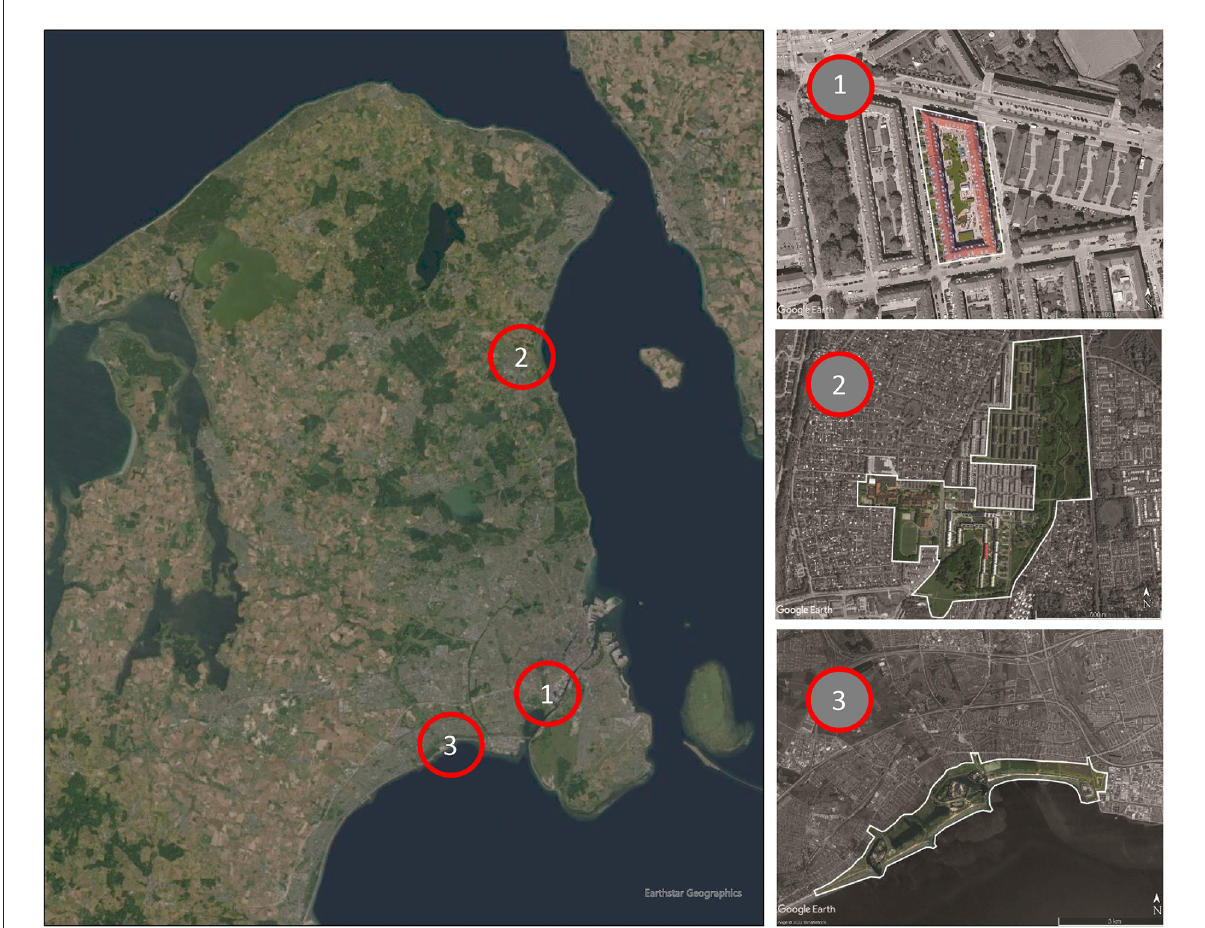
FIGURE1 Overview map of cases in Copenhagen’s regional structure. Case 1: Straussvej – local NBS storm water management in a residential courtyard in the City of Copenhagen. Small scale, 2020. Case 2: Kokkedal – district level NBS storm water management in a suburban area north